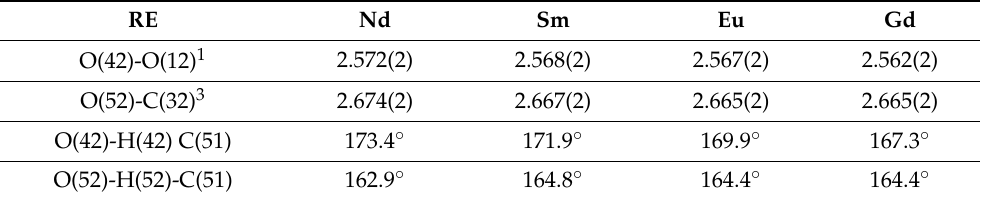
Table 5. Donor-acceptor distances [Å] and hydrogen bridging angles in the different compounds of the RE(OAc) 3 · 2AcOH structure type with standard deviations in